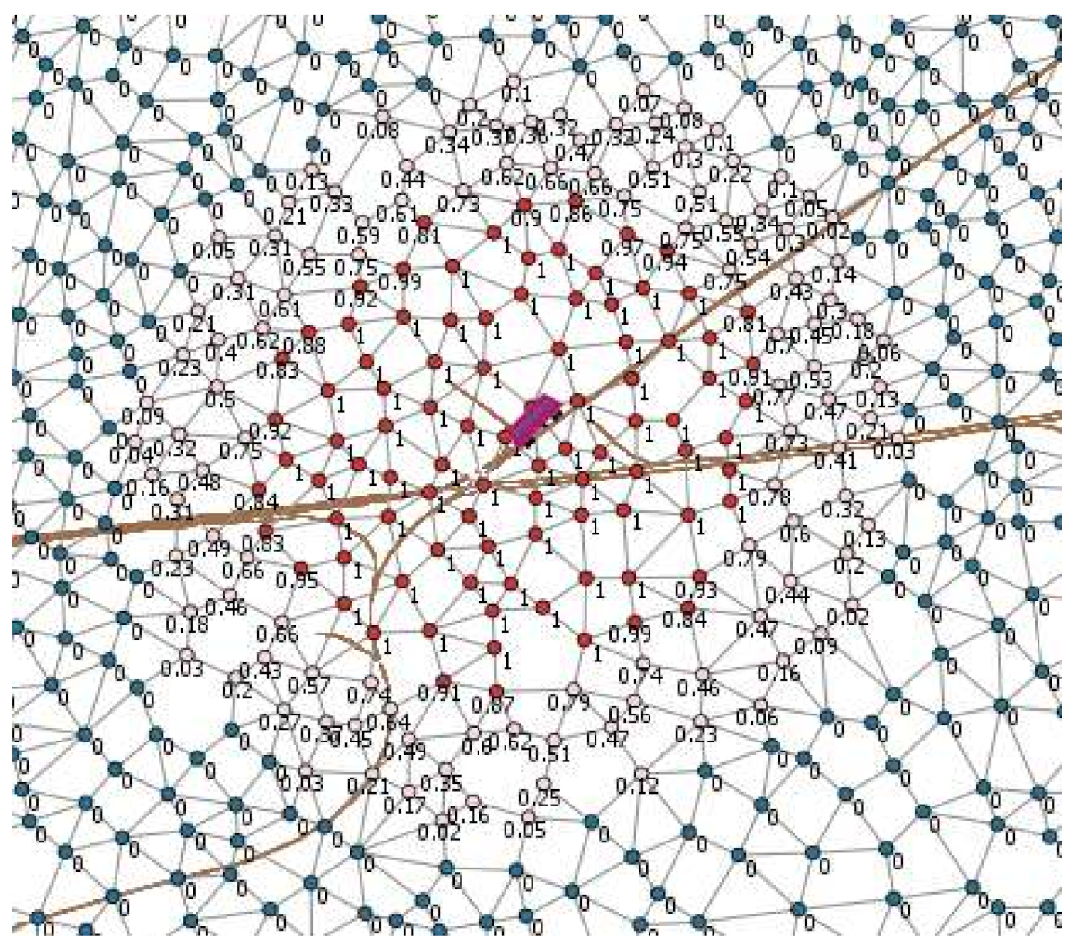
Figure 11. Sensor nodes showing their membership values to noise polluted area for a short trip of train: admitted membership value is